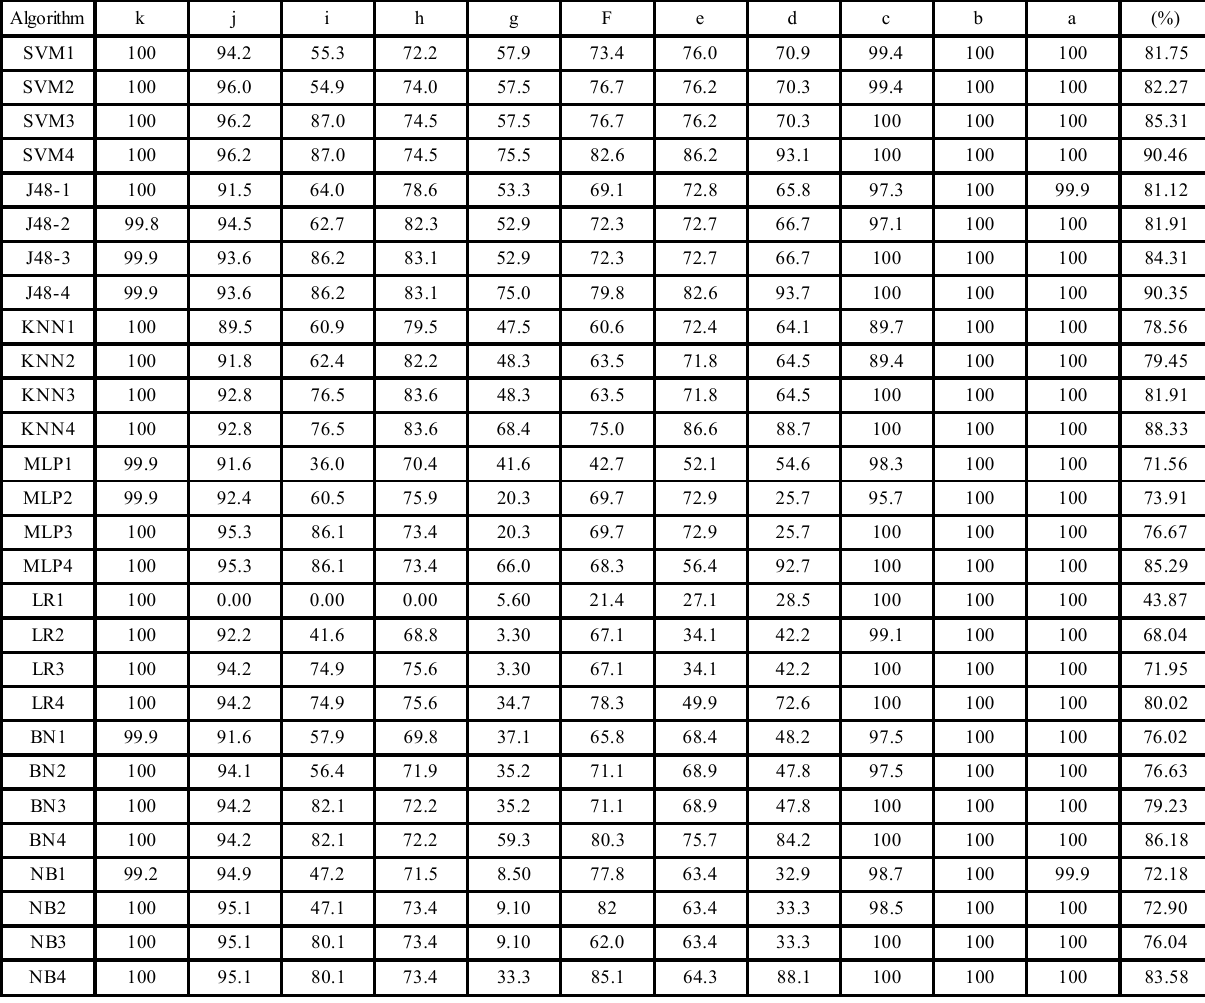
FIG. 9. RECOGNITION ACCURACY COMPARISON, 1 VS. 2 AND 3 GROUPS OF ACTIVITIES TABLE 5. RECOGNITION ACCURACY COMPARISON, 1 VS. 2, 3 AND 4 GROUPS OF